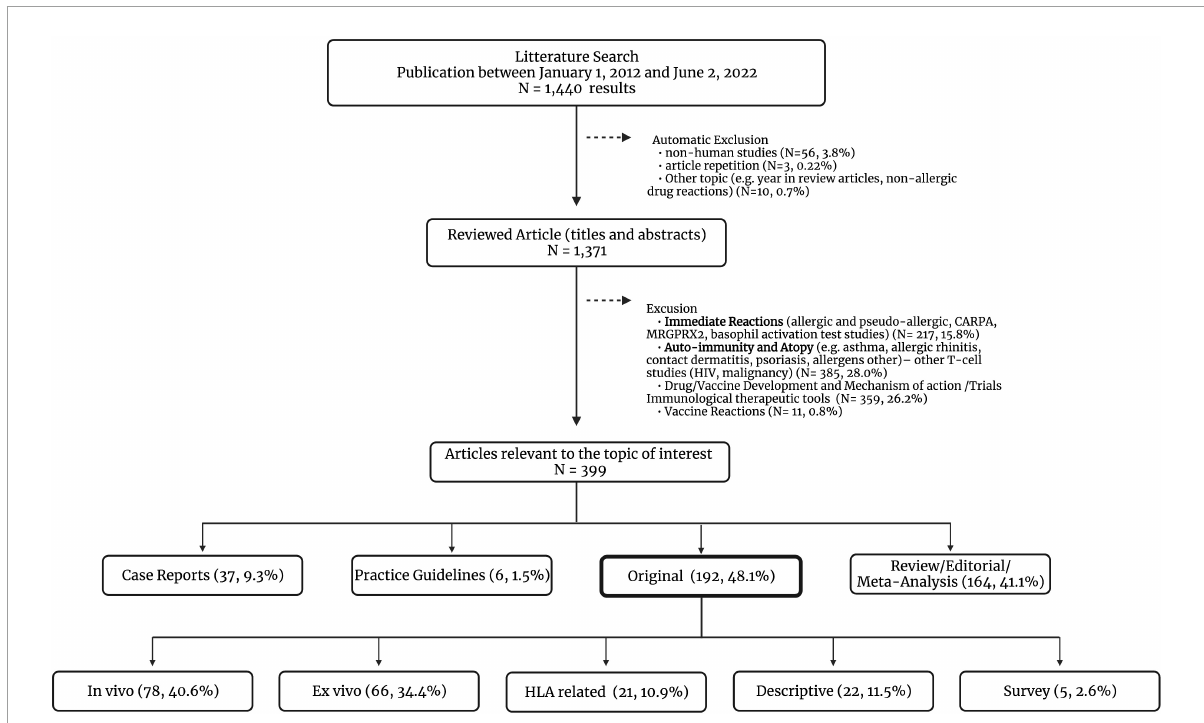
FIGURE1 Comprehensive literature review–article selection. CARPA, complement activation-related pseudoallergy; HIV, human immunodeficiency virus; HLA, human leukocyte antigen; MRGPRX2, Mas-related G-protein coupled receptor member X2. The ex vivo original studies can also describe the use of in vivo diagnostic tools in the methods or study